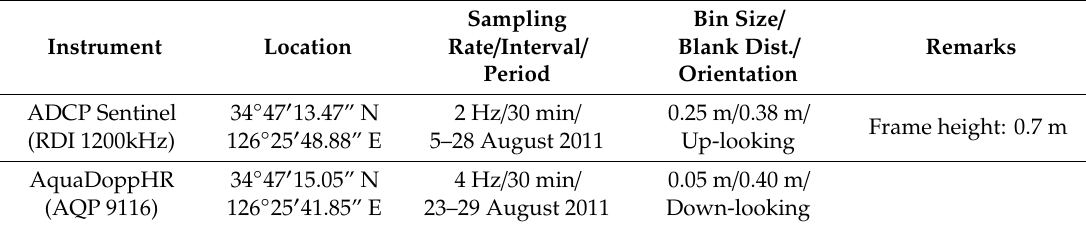
Table 1. Measurement scheme for the current meters in Yeongsan